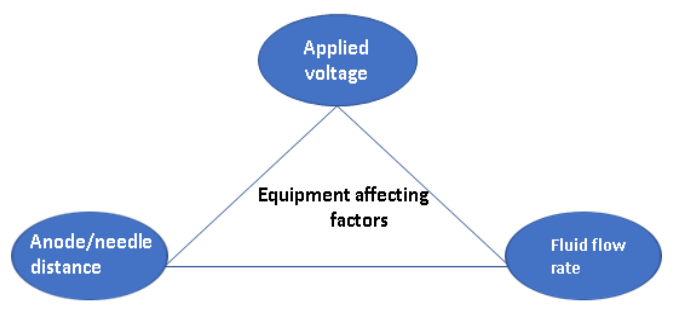
Figure 3. Equipment affecting